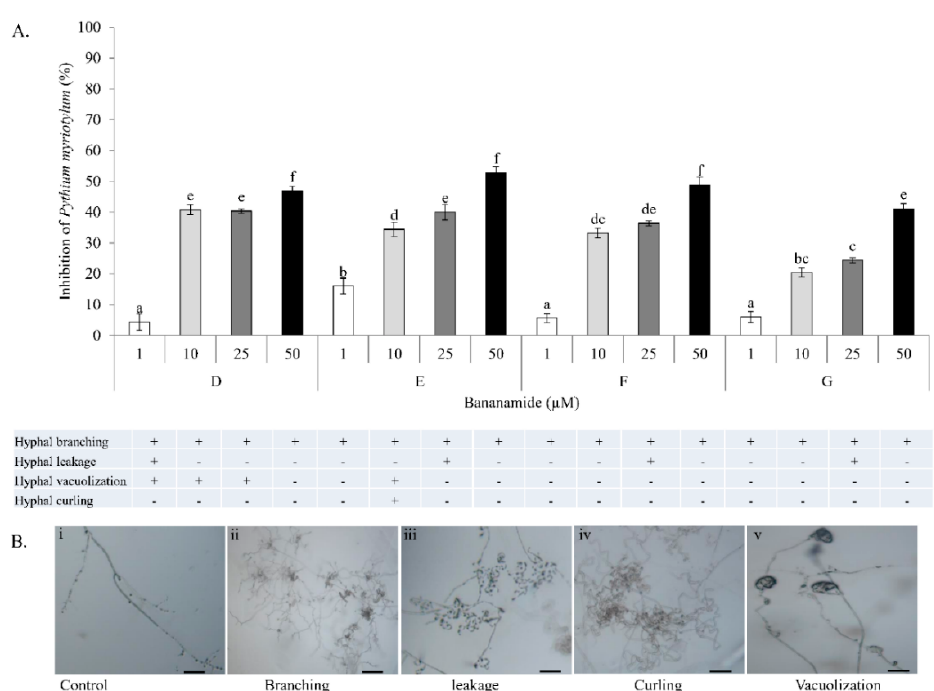
Figure 8. Effect of purified bananamide D-G on P. myriotylum CMR1. ( A ) Interaction between CLPs and P. myriotylum at concentrations ranging from 1 to 50 µM. Values plotted represent the percentage growth inhibition of P. myriotylum relative to the control. Vertical lines indicate standard deviations. Different letters (a, b, c, d, e, f) indicate statistically significant differences among different treatments (Anova followed by a Tukey’s tests: n = 5; α = 0.05), D: bananamide D; E: bananamide E; F: bananamide F; G: bananamide G. ( B ) Representative pictures showing various microscopic effects of pure bananamide D, E, F and G on P. myriotylum CMR1. Scale bars represent 10 µm.